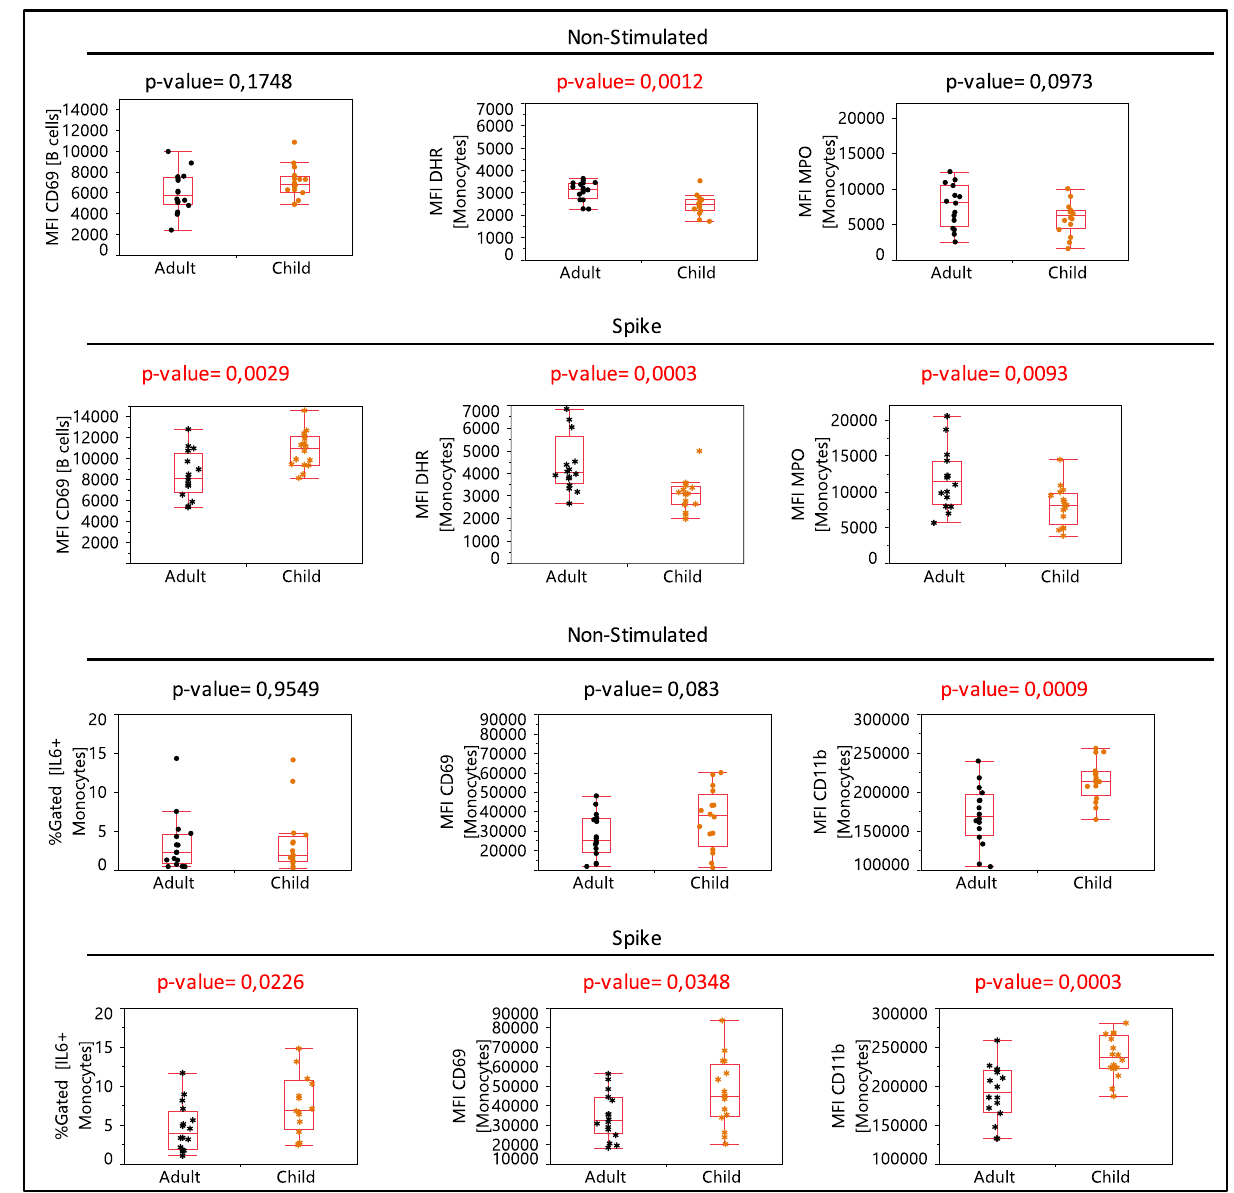
Figure 4. Representative box plots of the 6 parameters that differentially respond to spike stimulation (p-value equal or lower than 0.05) between adults and children. p-value in red color illustrates significative differences between child and adult